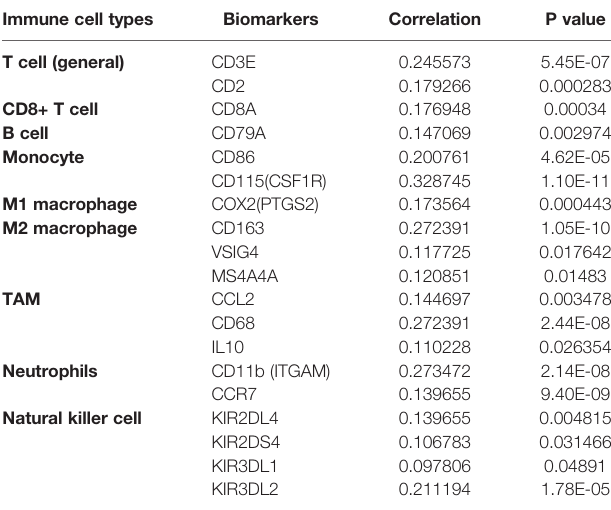
TABLE 1 | Correlation analysis between ARID1A and gene biomarkers of immune cells in COAD (TIMER). Immune cell types